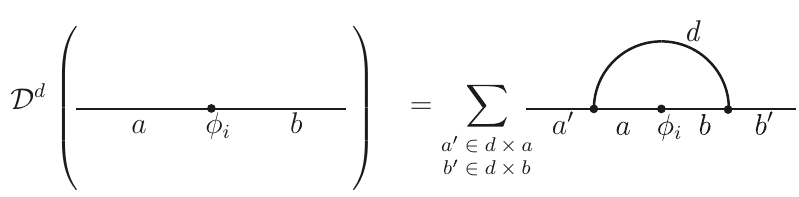
Figure 1 . Action of the topological defect on a boundary field φ ab with an open defect attached to the boundary. The result is a collection (direct sum) of boundary ′ b ′ fields φ a for all possible new boundary conditions allowed by fusion. The dots at the junctions i represent simple normalization factors determined in subsection